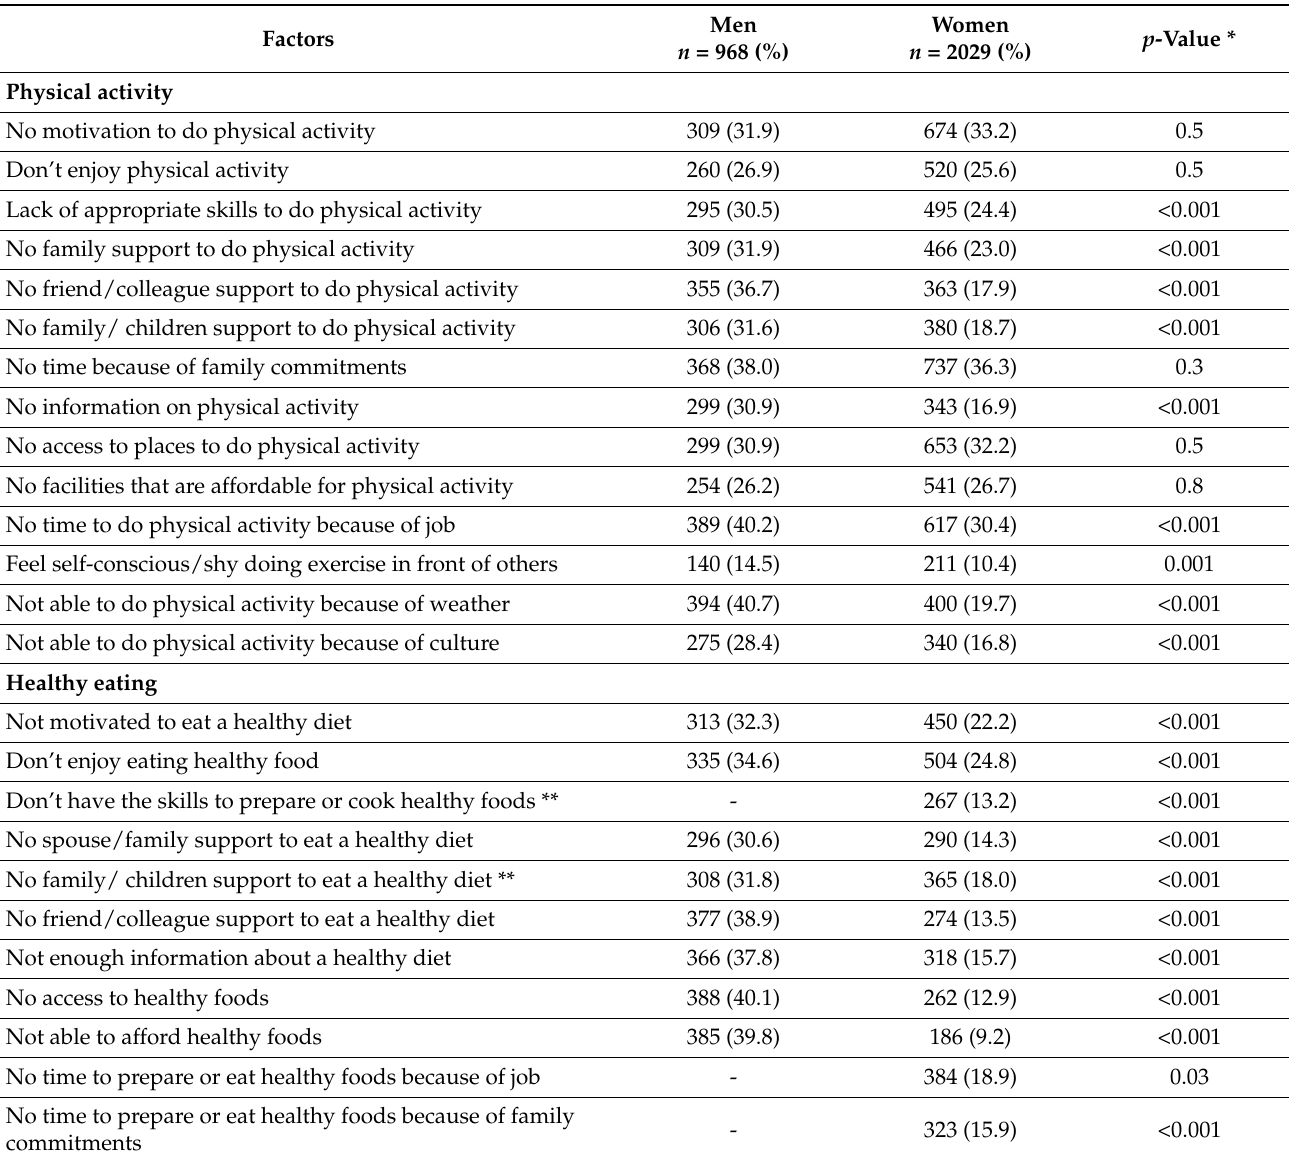
Table 3. The frequency of Saudi men and women reporting barriers for low physical activity and unhealthy eating habits in Riyadh, Saudi